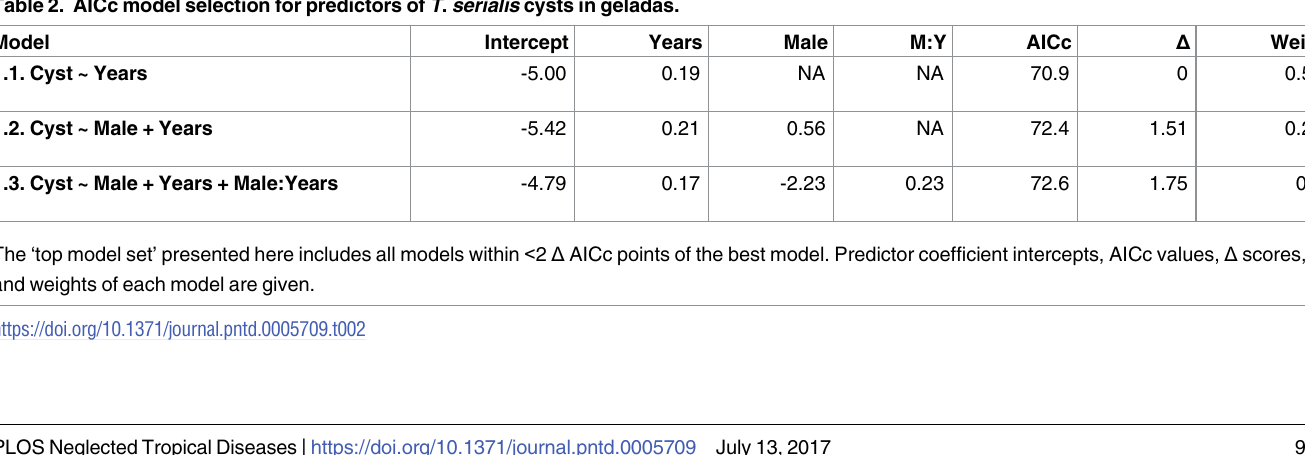
Table 2. AICc model selection for predictors of T . serialis cysts in geladas. Model